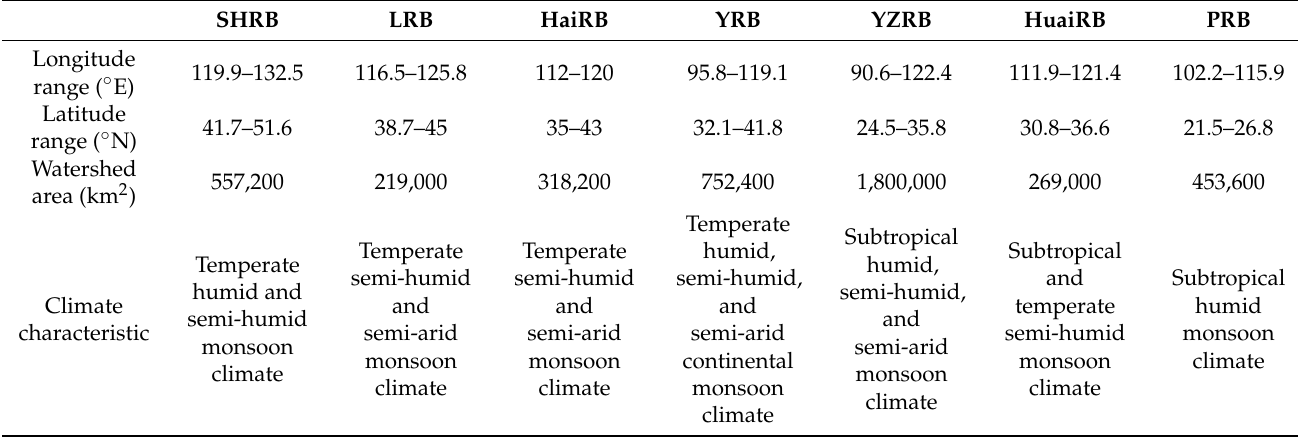
Table 1. Detailed information on seven major watersheds in